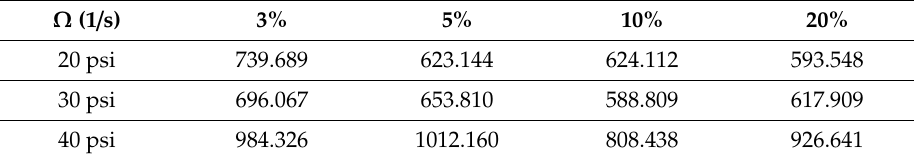
Table 3. Maximum time-averaged vorticity measurements at maximum x